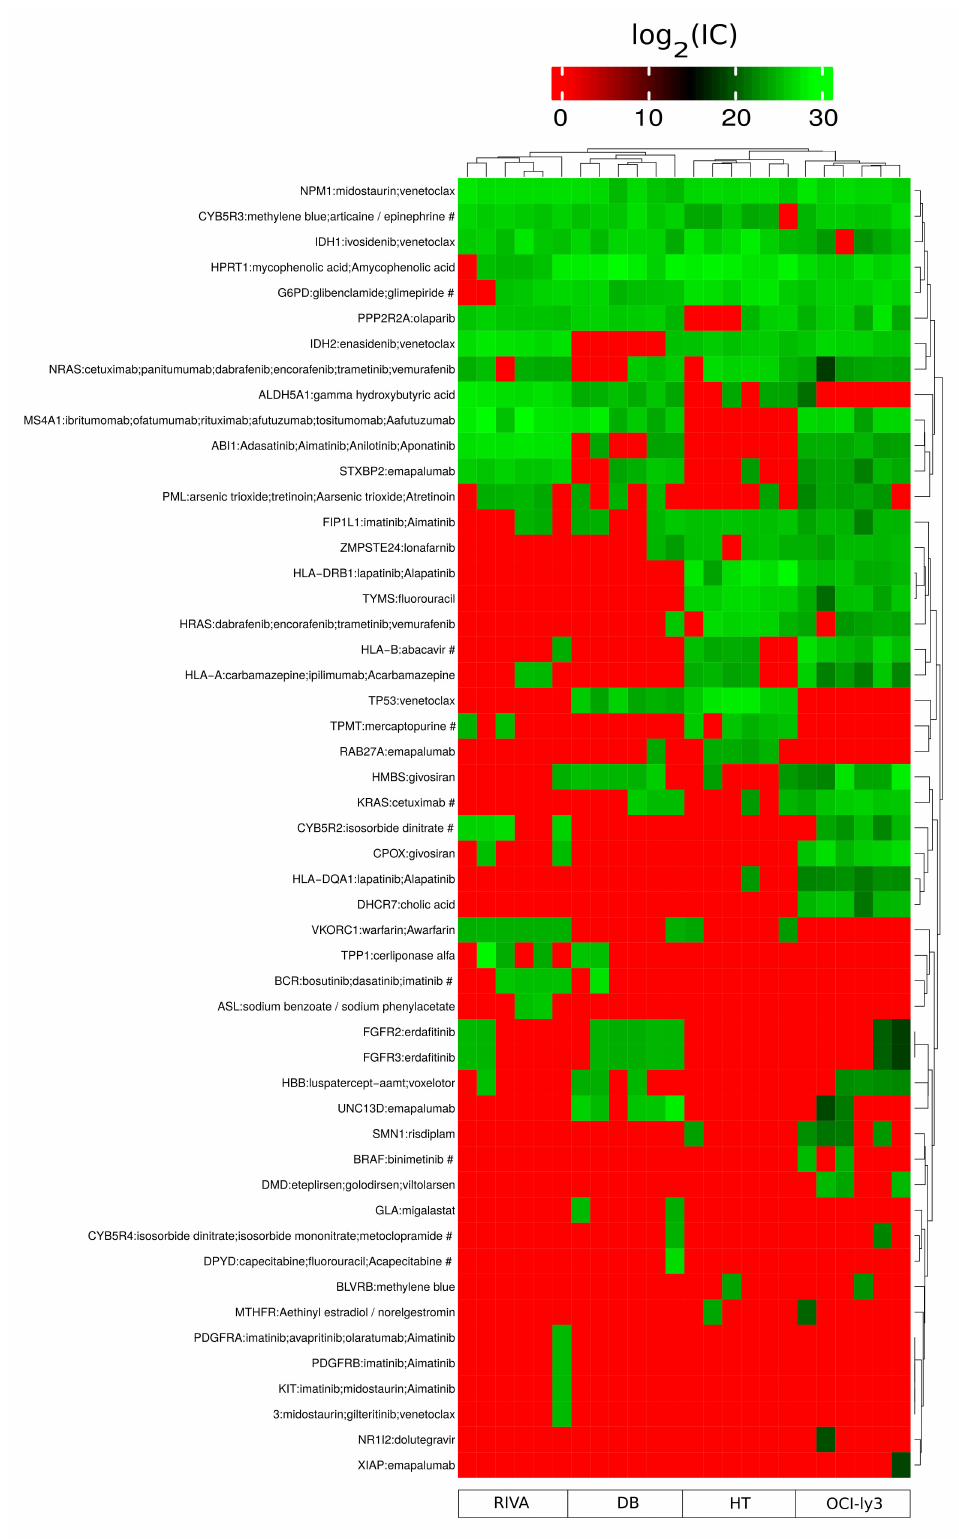
Figure A8. Protein expression values (log 2 (iBAQ)) for proteins targeted by approved